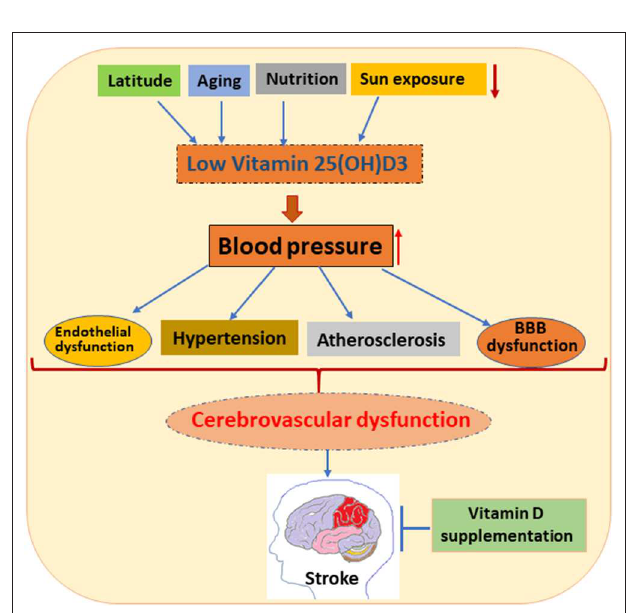
FIGURE 2 | Schematic diagram represents the effects of low 25(OH)D 3 on various vascular-related functions such as endothelial function, hypertension, atherosclerosis, and blood brain barrier (BBB) dysfunction. Various factors, such as latitude, aging, nutrition, and sun exposure cause VDD, which affects blood pressure. Elevated blood pressure causes vascular impairments, leading to cerebrovascular impairment and thus stroke in patients. Many clinical and preclinical studies show that VD supplementation improves stroke outcome.